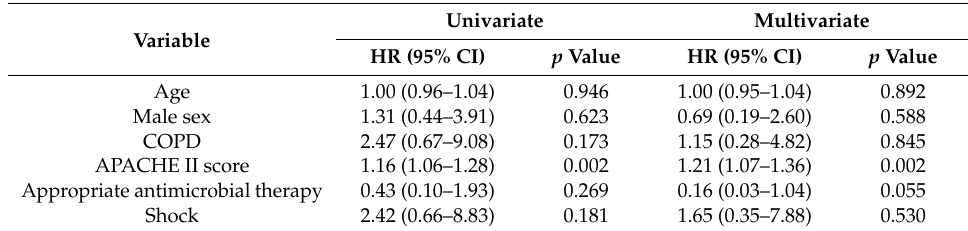
Abbreviations: COPD, chronic obstructive pulmonary disease; APACHE, Acute Physiology and Chronic Health